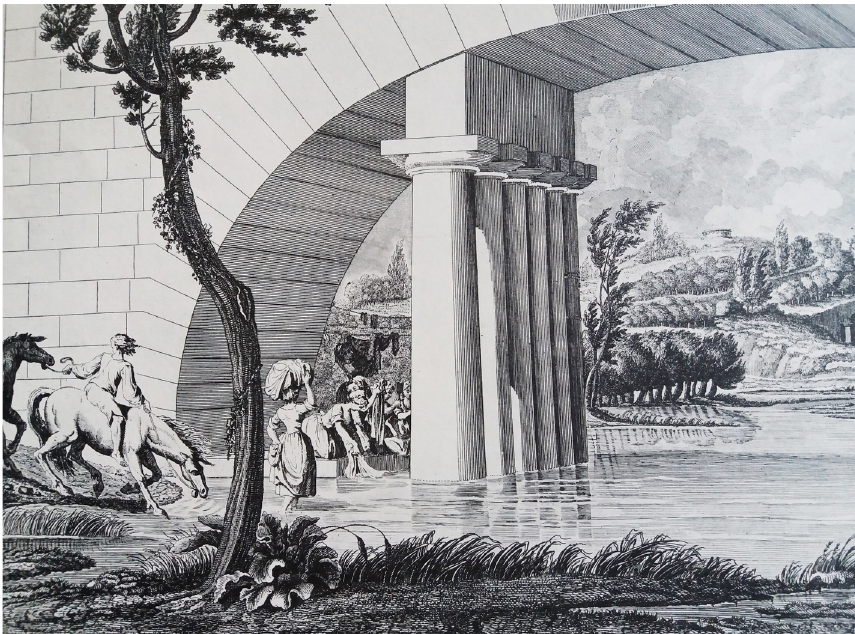
Claude-Nicolas Ledoux, “abreu- voir et lavoir de Meilliand,” detail. From Claude-Nicolas Le- doux, L’architecture considérée sous le rapport de l’art ,